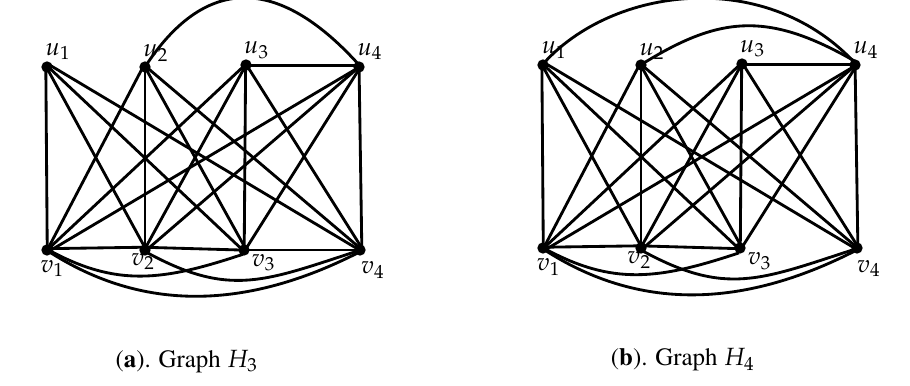
Figure 3. The graphs H 3 and H 4 .